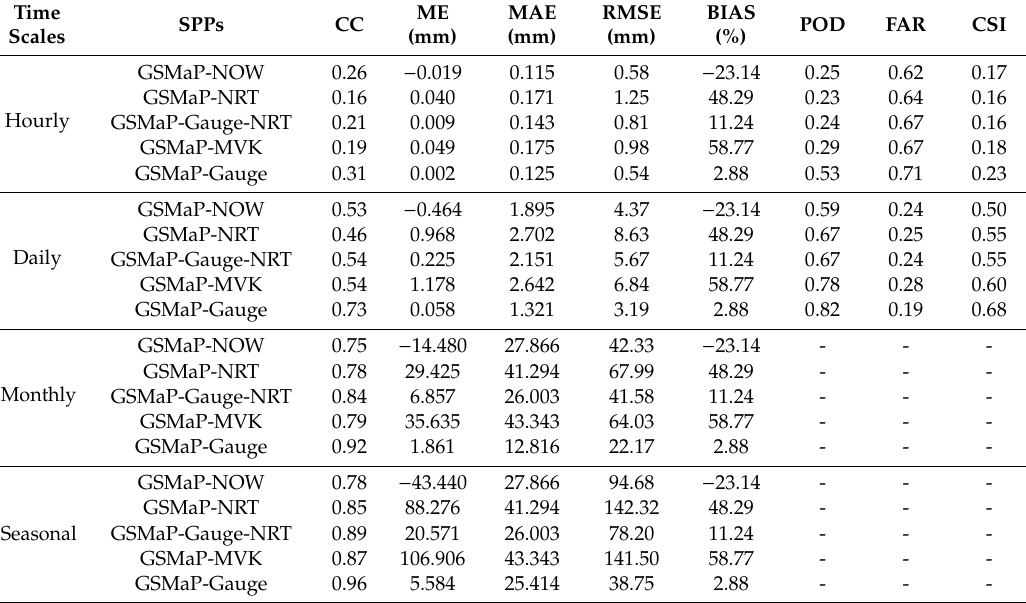
Table 5. Summary of statistical metrics of precipitation estimates from global satellite mapping of precipitation (GSMaP) SPPs at hourly, daily, monthly, and seasonal scales from 29 March 2017 to